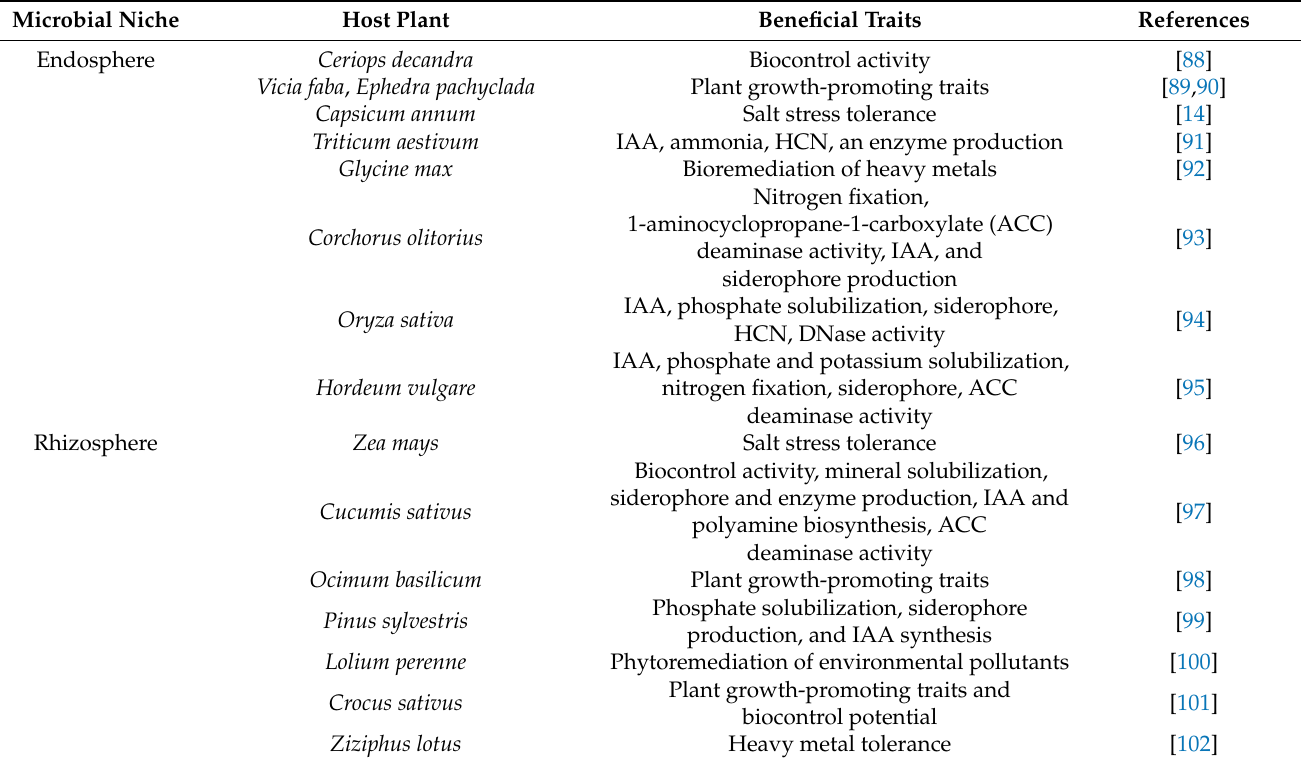
Table 1. Plant growth-promoting traits of some beneficial endophytic and rhizosphere microbes. Microbial Niche Host Plant Beneficial